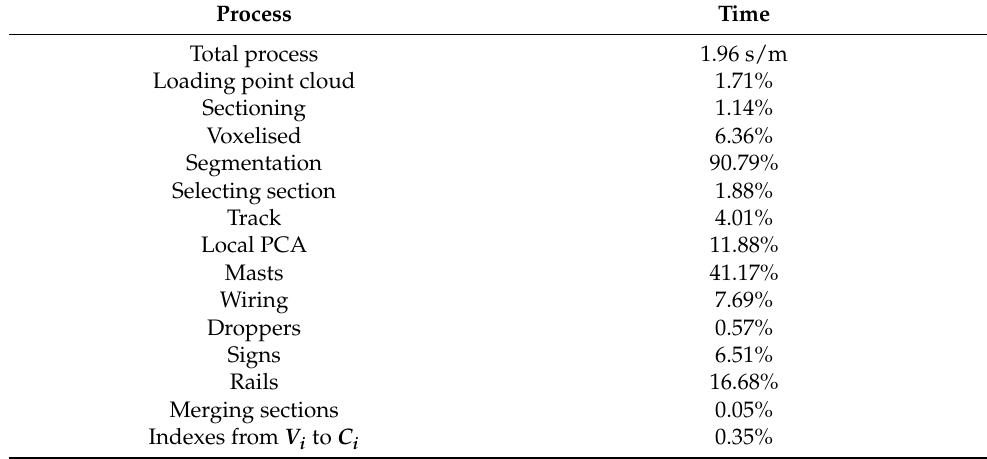
Table 6. Processing